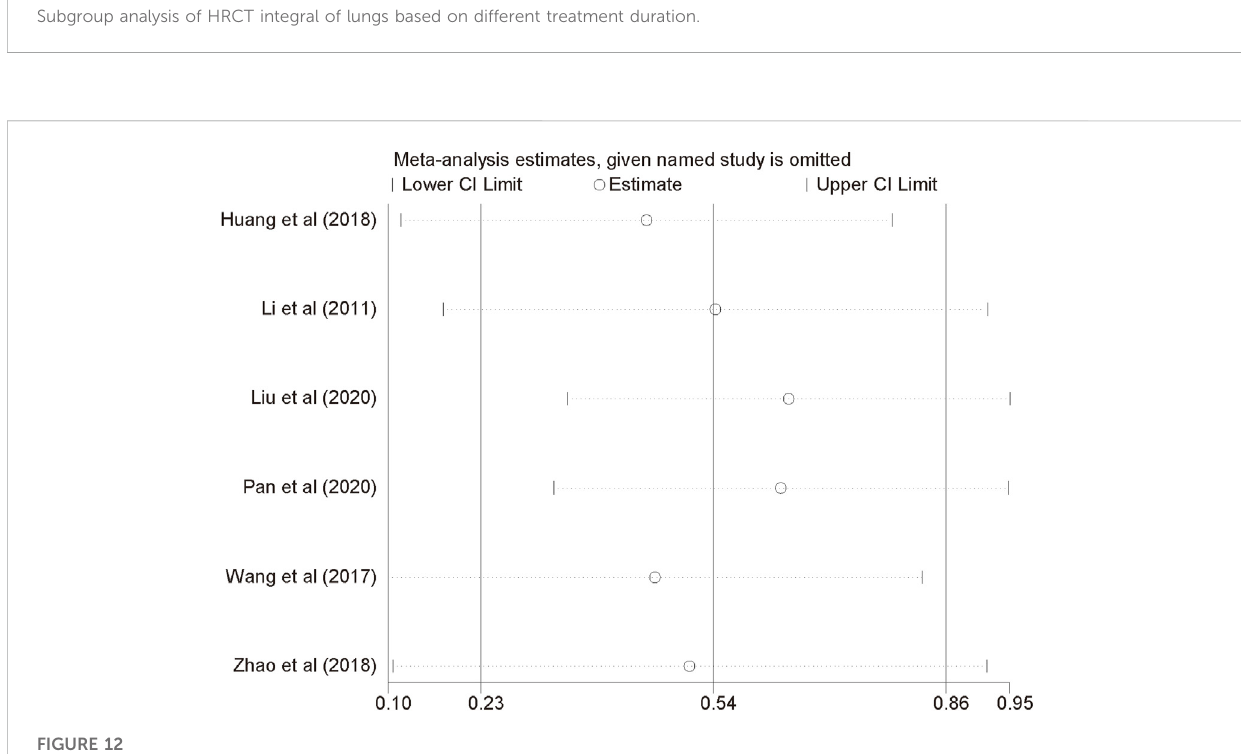
FIGURE 12 Sensitivity analysis plots of